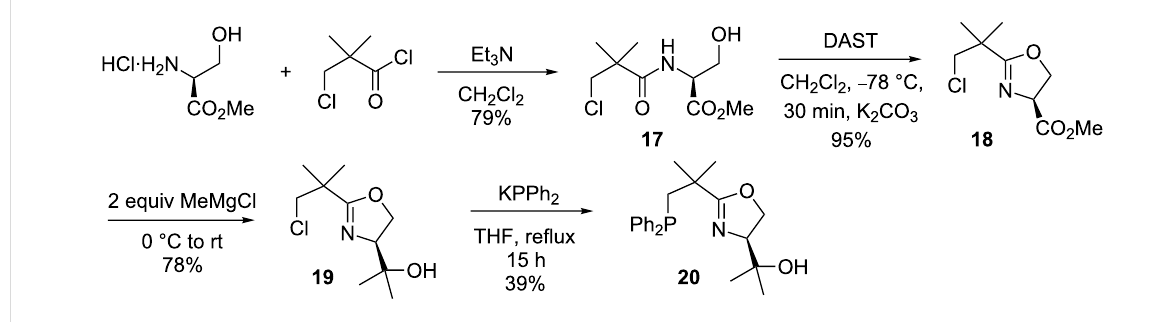
Scheme 6: Synthetic strategy for the synthesis of the serine-derived NeoPHOX ligand.